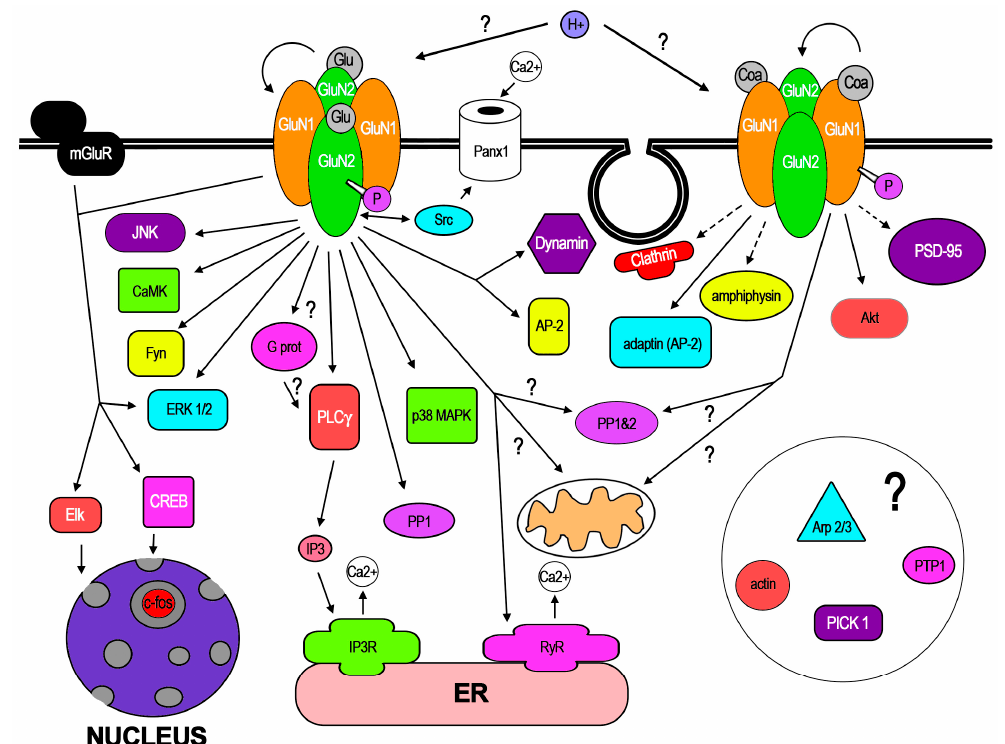
Figure 2. Molecular mediators, pathways, and organelles involved in f-iNMDARs. The molecular mediators pathways and organelles associated with f-iNMDARs are organized into those activated by the GluN2 subunit ( left ), those activated by the GluN1 subunit ( right ), or those not yet determined ( center; arrows with question marks ). In the case of G proteins activated by the GluN1 subunit, question marks indicate that only indirect evidence has been gathered. For extracellular H+, the question marks indicate that it is not clear which subunit mediates the induction of f-iNMDARs. Bracketed lines indicate an indirect relationship, such as the relationship with PSD-95 (known to bind GluN2 subunits) that is induced by GluN1 activation. The arrow loops from one subunit to the other indicates transfer of structural information between subunits. Those mediators only inferred to participate are encircled in the bottom right corner with a question mark (for details, please refer to